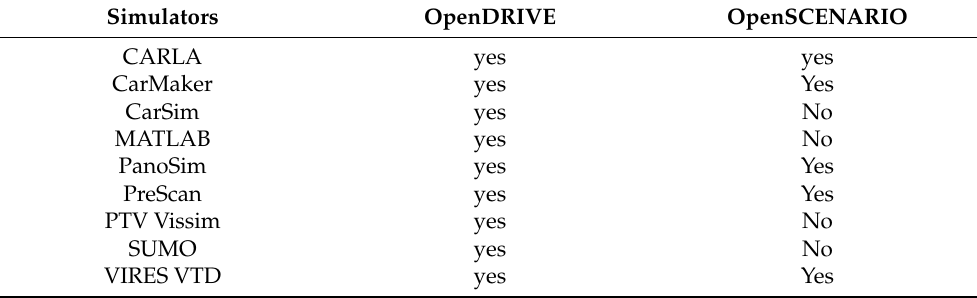
Table 2. Scenario file support for common